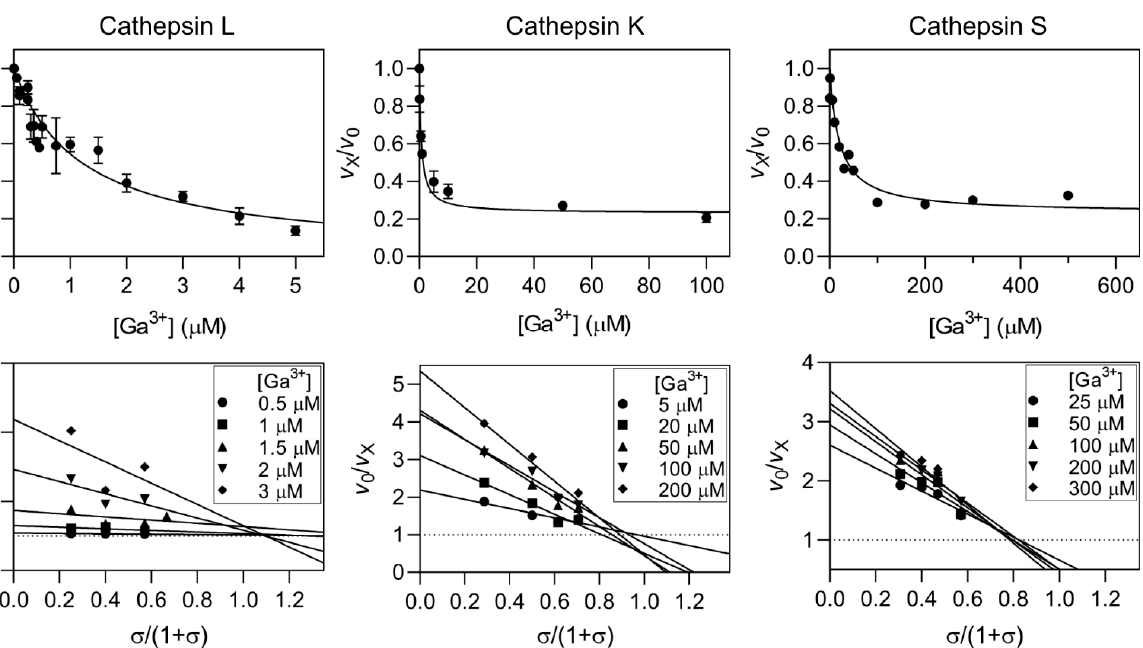
Figure 4. Inhibition of cathepsins L, K, and S by Ce 4+ ions. The titration curves are shown in the upper panels and the specific velocity plots used to determine the inhibition mechanisms are shown in the lower panels. Activity was measured with synthetic fluorogenic substrates (Z-Leu-Arg-AMC, Z-Phe-Arg-AMC and Z-Val-Val-Arg-AMC for cathepsins L, K, and S, respectively) at 25 °C in 0.1 M sodium acetate buffer pH 5.5. σ is equal to [S]/ K m . The error bars in the titration curves represent the S.E.M. of multiple independent experiments.